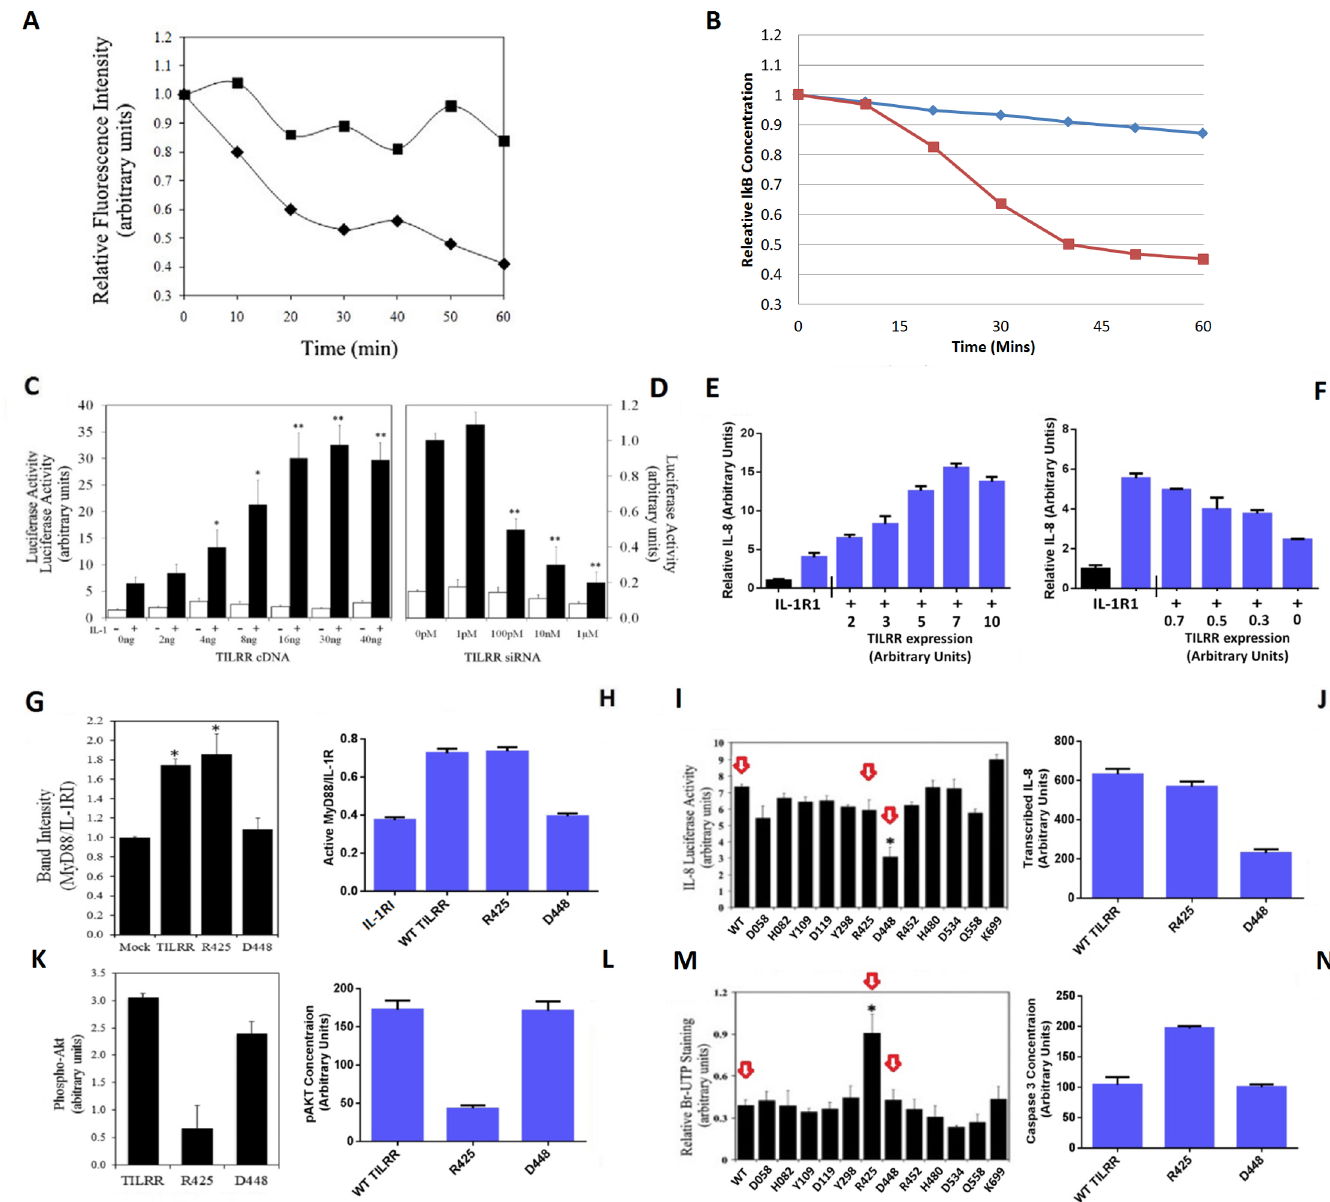
Fig 4. The model accurately reproduces activation of inflammatory and anti-apoptotic signals, controlled through IL-1RI and TILRR. A. TILRR siRNA decreases I κ B α degradation in HeLa cells transfected with I κ B α -EGFP (7 μ g/10 6 cells) alone or in the presence of random ( ♦ ) or TILRR-specific ( ■ ) siRNA and stimulated with IL-1 (1 nM). Graph show continuous readings from three experiments including 55 cells, p < 0.05 at 60 min. B. Simulations using the best-fit model, show reductions in transfected I κ B α -EGFP degradation during IL-1 β stimulation in the presence (Red) and absence (Blue) of TILRR, and are in agreement with published data (A). C, D. TILRR cDNA increases (C) and TILRR siRNA decreases (D) IL-8 luciferase activity in HeLa cells treated with IL-1 β (1nM, 6 hrs.) (Mean ± SEM, n = 3, * p < 0.05; ** p < 0.01). E, F. Simulations of un-stimulated levels (black) and IL-1 β -induced IL-8 activity (blue) in the presence of the IL-1RI complex and with increasing (E) and decreasing (F) TILRR expression relative to endogenous levels, using the agent-based model, show agreement with in vitro data in C and D. (Mean ± SEM, n = 3, 0.005 < p < 0.03, E. TILRR expression levels 2 – 10, F. TILRR expression 0.3, 0). G, H. MyD88 recruitment to the IL-1RI complex during IL-1 β stimulation (20 min, 1nM), is enhanced following transfection with wild type (WT) TILRR or the R425 TILRR mutant, while substitution at residue D448, abrogates the effect. In vitro experiments (G) (Mean ± SEM, n = 3, * p < 0.005) and model simulation (H) (Mean ± SEM, n = 3, WT vs. D448 p < 0.0.001). I, J. Mutation of residue D448 results in a 60% reduction in inflammatory gene activity, while other mutants have no impact (I) (arrows indicate WT TILRR and the R425 and D448 mutants, Mean ± SEM, n = 3, * p < 0.001). Model simulations (J) similarly show a pronounced reduction in the presence of the D448 mutant, but no effect by substitution of R425. (Mean ± SEM, n = 3, WT vs. D448 p < 0.001). K, L. TILRR- induced increase in levels of phosphor-Akt by IL-1 β (1nM) is blocked following mutation of residue R425, while substitution at D448 has the same effect as the wild type co-receptor. In vitro experiments (K) (Data are expressed relative to levels in mock transfected cells, Mean ± SEM, n = 3, WT vs. R425, p < 0.01),